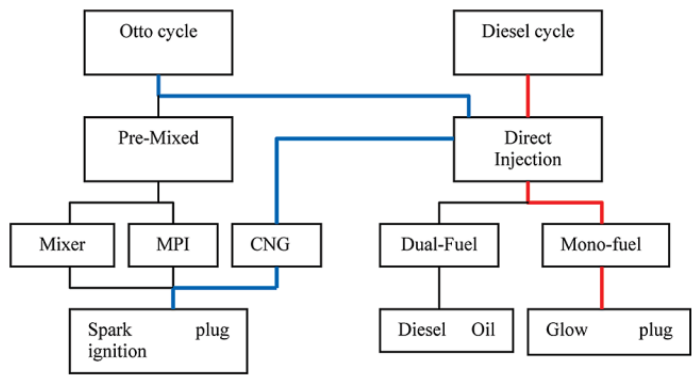
Figure 6. Combustion modes for compressed natural gas (CNG) in internal combustion (IC) engines